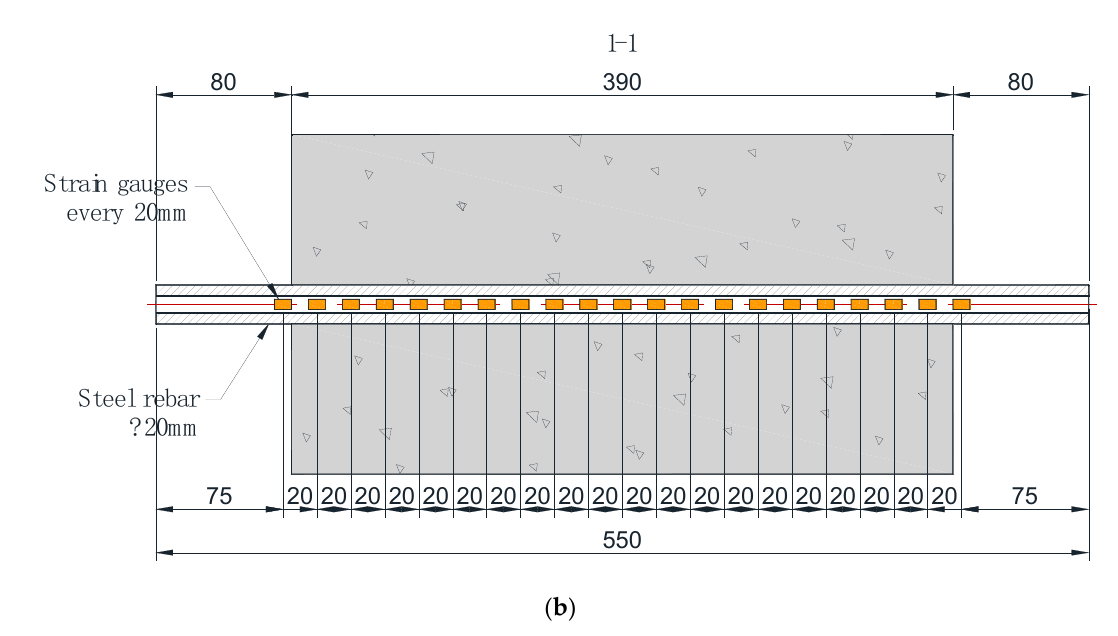
Figure 1. Installation and placement of strain gauge sensors in embedded reinforcement: ( a ) cross- section of the specimen with glued strain gauge sensors inside the modified rebar in detail; ( b ) longitudinal section of the specimen with strain gauge arrangements inside the embedded rebar.